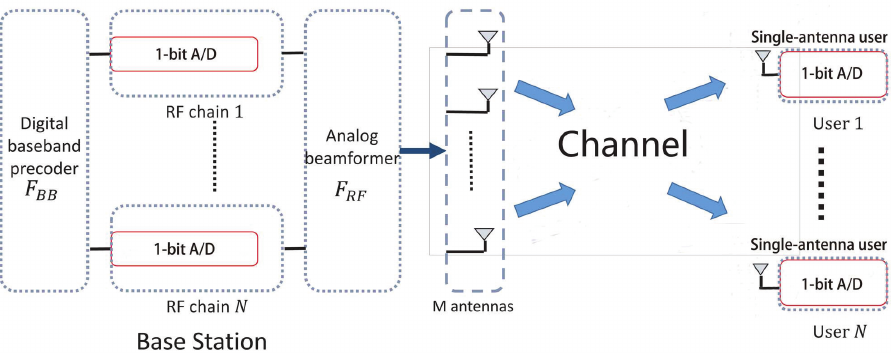
Figure 1. The considered hybrid mmWave system with 1-bit A/D equipped at transceivers for strongest AoA components